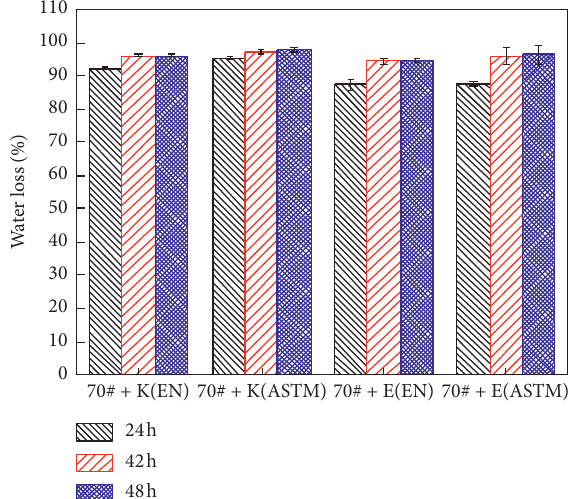
Figure 3: Loss percentage of the water content of the emulsified